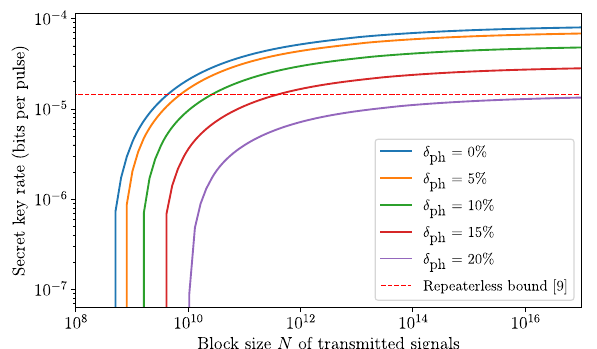
Fig. 3 Secret-key rate obtainable as a function of the block size N . We assume a total loss of 50 dB and consider several values of the phase reference mismatch δ ph . All other simulation parameters are stated in the main text.